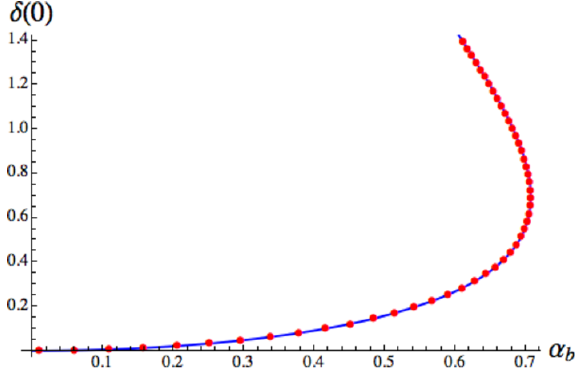
Figure 12 . (cid:14) (0) vs (cid:11) , numerical (red dots) and analytical (blue curve). the unstable branches. The agreement is perfect: the numerically determined maximum of (cid:14) (0) for the stable branch is located at (cid:11) = 0 : 7071067, where (cid:14) (0) = 0 : 693148. The p expected results are (cid:11) = 1 = 2 = 0 : 7071068 and (cid:14) (0) = log(2) = 0 :